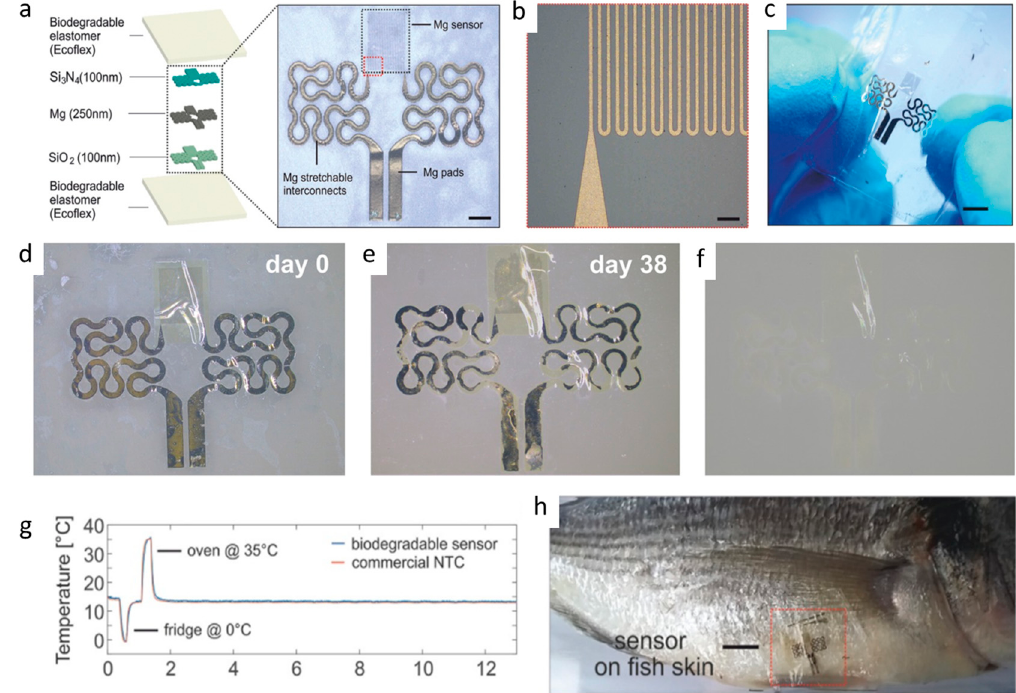
Figure 40. ( a ) The sensor consists of Mg serpentine, interconnections and contact pads. Si 3 N 4 , SiO 2 and Ecoflex are used as encapsulation layers. ( b ) Optical micrograph or a part of the serpentine sensing element (scale bar 50 μ m). ( c ) Picture of the whole biodegradable sensors (scale bar 1 mm). Image of the sensor ( d ) before immersion in water–NaCl solution (150 mmol) at 25 °C, then ( e ) after 36 days and ( f ) after 67 days. ( g ) Temperature measurement using the biodegradable sensor, compared with a conventional negative temperature coefficient (NTC) thermistor. ( h ) Example of use: the sensor is stick on a fish to track shipping and storage temperatures. Adapted from [162] with permission. ©